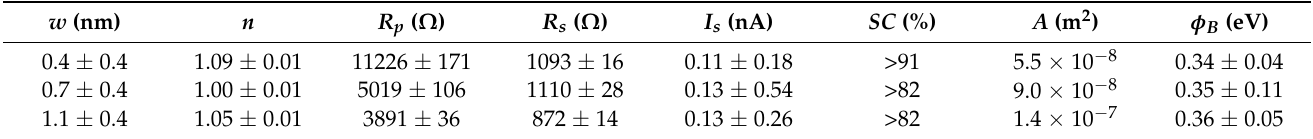
Table 3. Fitted parameters of I–V curves as a function of wall